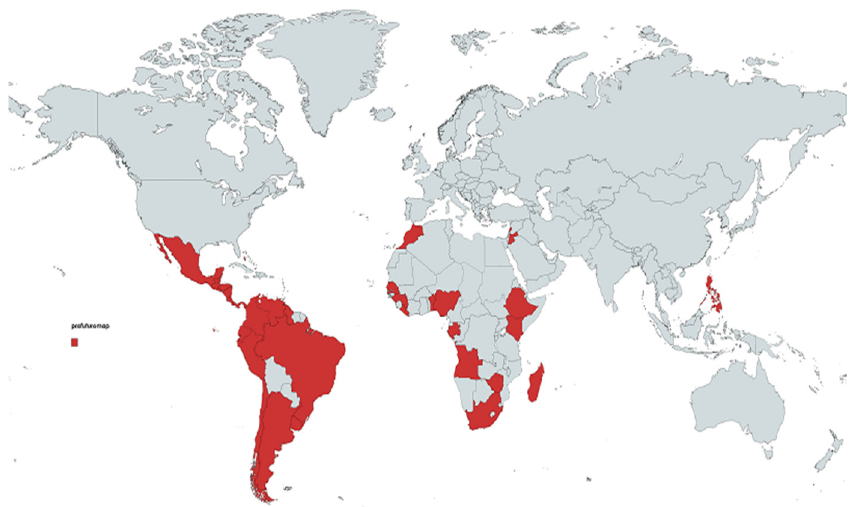
Figure 1. ProFuturo map.